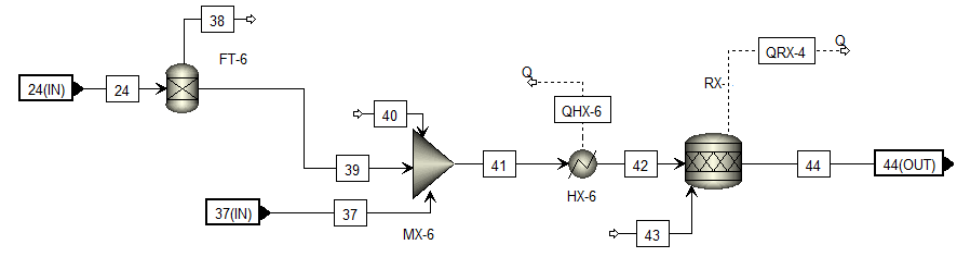
Figure 4. Fermentation stage flowsheet in topology 1.